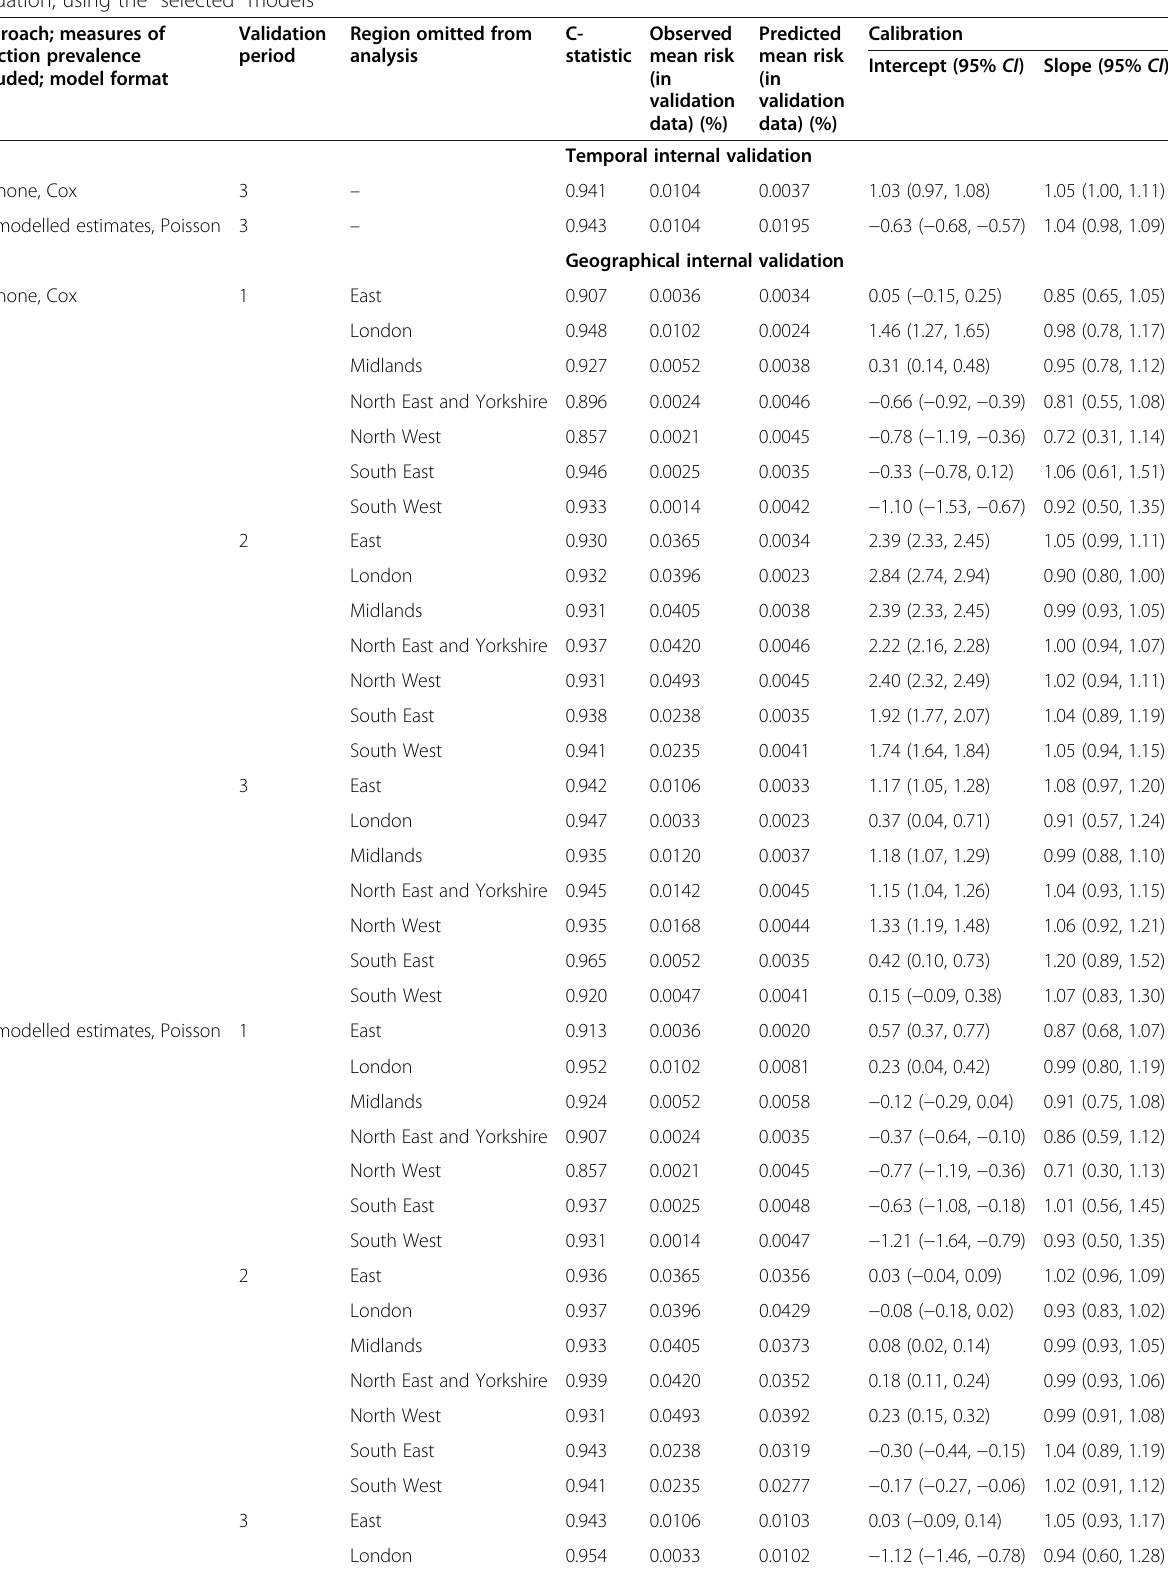
Table 4 Measures of model performance in predicting 28-day risk of COVID-19 mortality in the temporal and geographical internal validation, using the “ selected ”